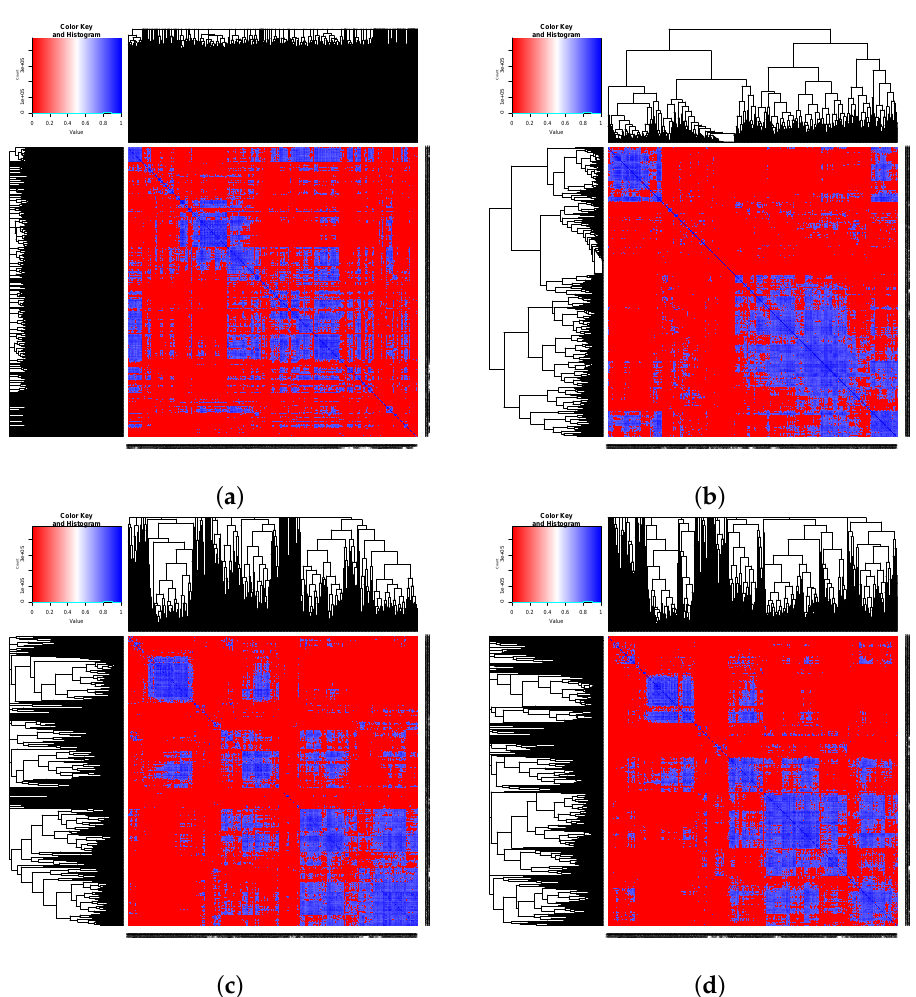
Figure 3. Visualizations of the correlation matrix after hierarchical clustering using complete linkage method with chosen distance functions: ( a ) Maximum, ( b ) Manhattan, ( c ) Canberra, ( d )